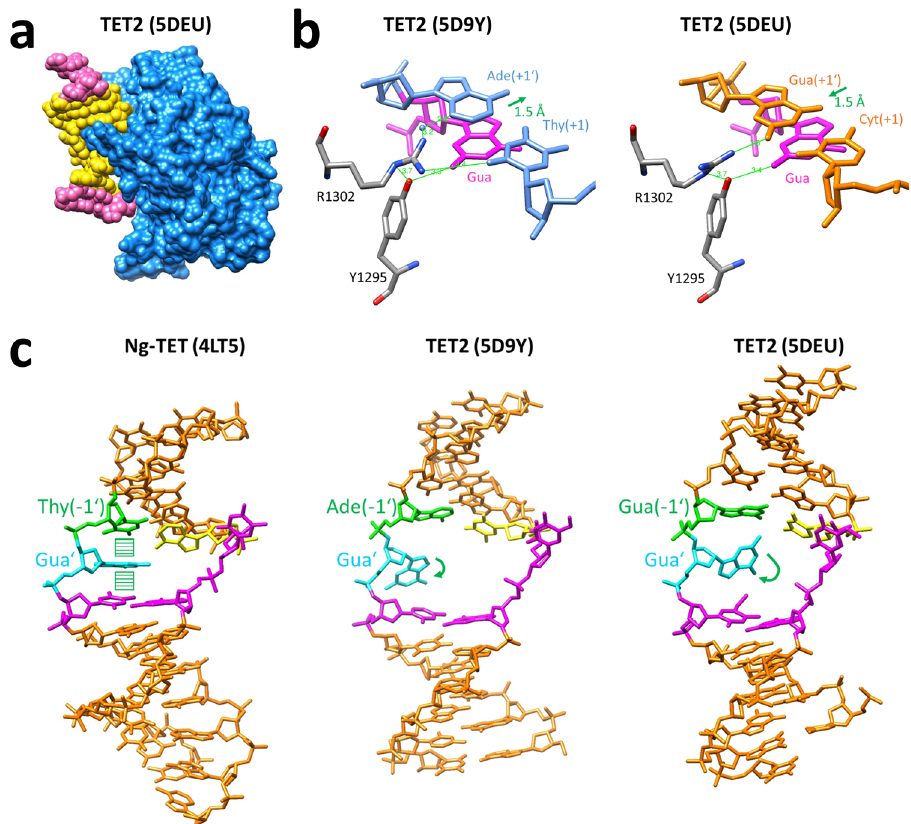
Fig. 6 Structural details of TET enzyme-DNA complexes. a Structure of TET2 with the − 3 to + 2 fl anking region of the DNA colored in yellow. b Comparison of two TET2 structures revealing altered positions of the + 1 fl ank base pair (shown in blue and orange) and changes in the hydrogen bonding network (green lines) involved in the recognition of Gua ’ (shown in purple). c Comparison of three TET structures revealing different conformations of the Gua ’ (shown in cyan) depending on the − 1 fl anking base pair (shown in green and yellow). The other residues of the CpG site are shown in